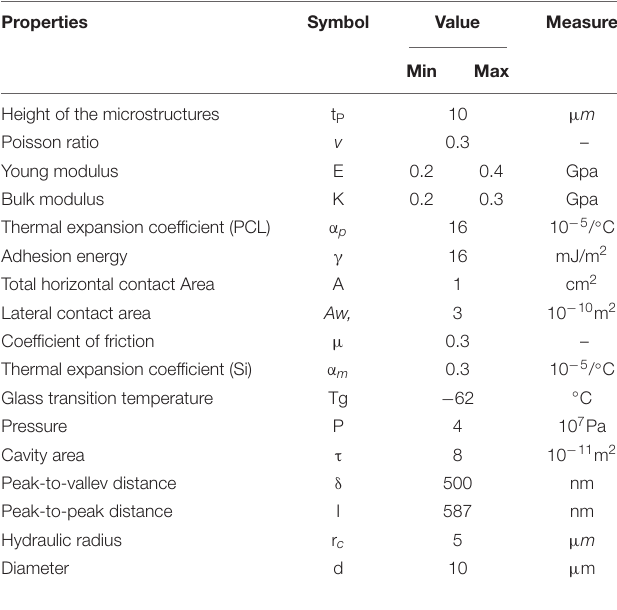
TABLE 1 | Values of the different parameters used for the analytical model (the Young modulus and Bulk modulus range is due to the fact that different types of PCL were found in